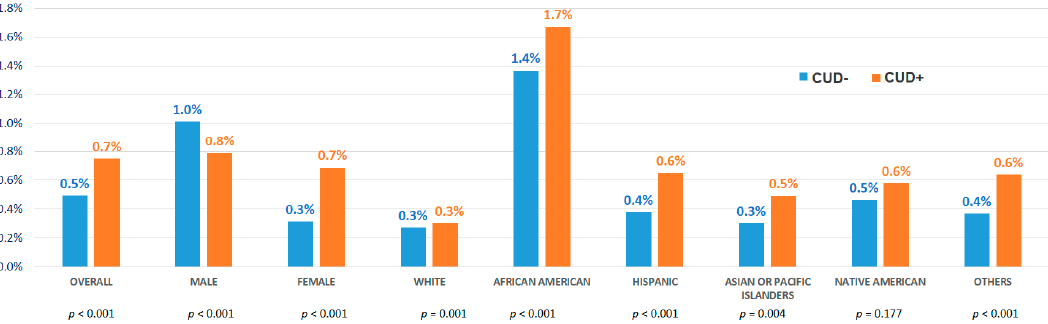
Figure 1. Hypertensive Crisis-related Hospitalizations in Young Adults (18–44 years) With vs. Without Cannabis Use Disorder. Table 2. Association Of Cannabis Use Disorder With Hypertensive Crisis-related Hospitalizations In Overall Young Adult Population Additionally, Young Adults With Known Benign